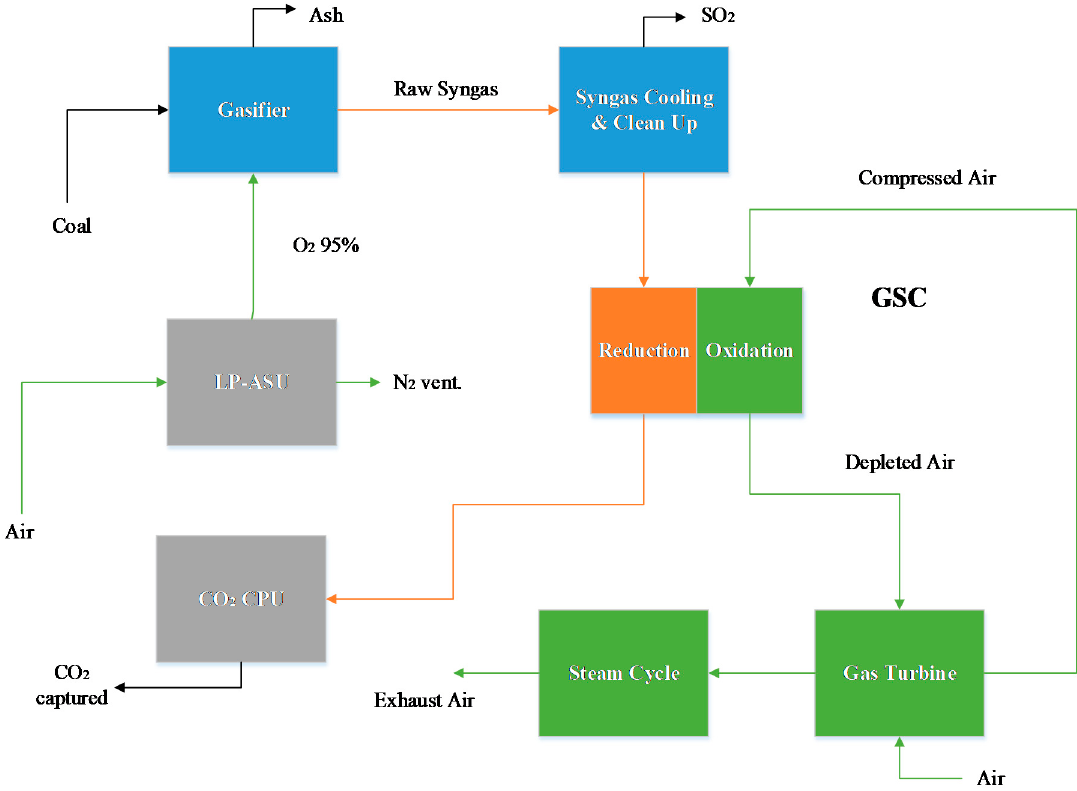
Figure 4. Block flow diagram of the GSC IGCC plant.